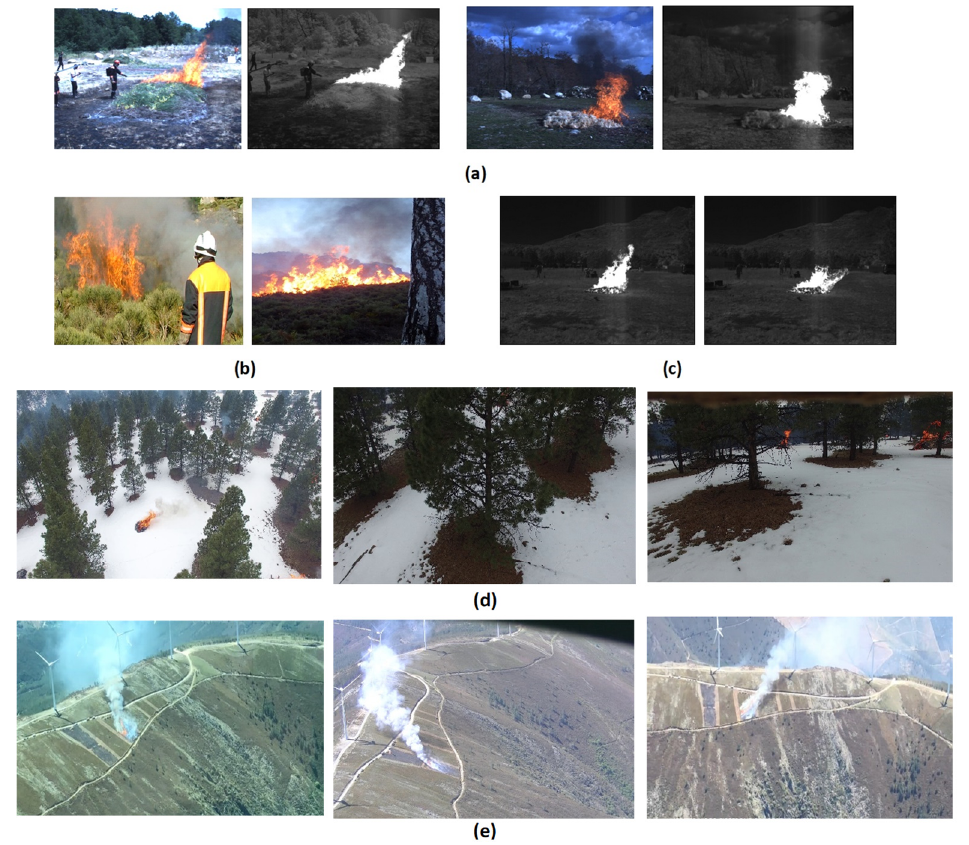
Figure 2. Examples of fire pictures are included in our simulation dataset: ( a ) Multimodal, ( b ) RGB spectra, ( c ) IR spectra pictures taken from the Corsican dataset. ( d ) RGB pictures from FLAME dataset, ( e ) pictures from Firefront_Gestosa.